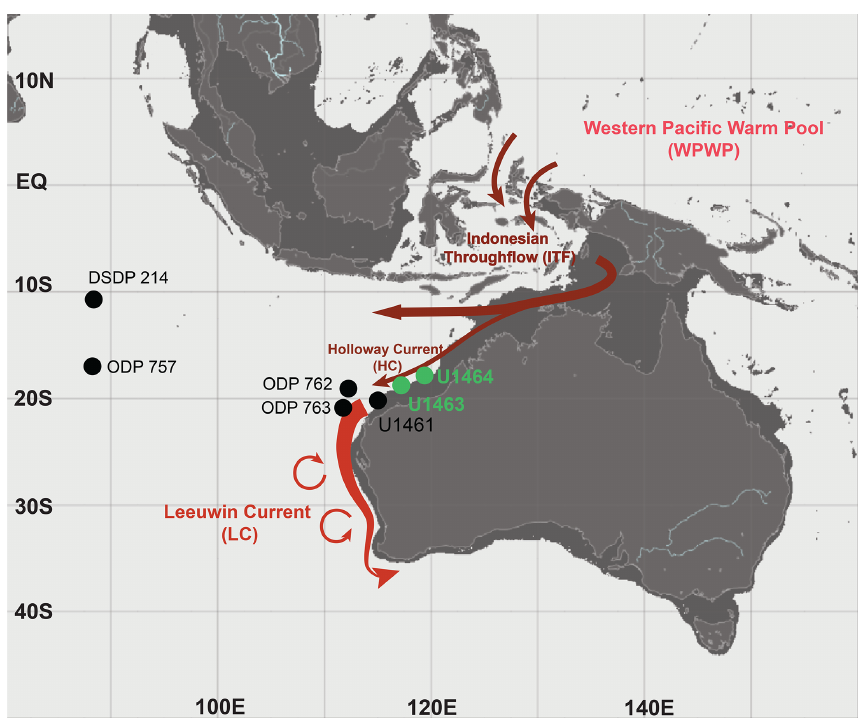
Figure 1. Modern bathymetric map indicating shelf environments ( < 200m depth; dark-grey shading) and site locations. IODP Sites U1463 and U1464 (NW Australian shelf; green dots) are the primary sites of investigation in this study. Other sites discussed in the text (black dots) include IODP Site U1461 (NW Australian shelf), ODP Sites 762 and 763 (eastern Indian Ocean), and ODP Site 757 and DSDP Site 214 (equatorial Indian Ocean). The main surface oceanography of the Indo-Pacific region, including the Indonesian throughflow (ITF; dark-red arrows) and the main path of the Leeuwin Current (LC; lighter-red arrow; adapted from Auer et al., 2019; Gallagher et al., 2009) and the Holloway Current (HC), which in this study are considered as one, are shown. The base map was generated using the ocean data visualisation tools of EU Copernicus Marine Service Information (MyOcean